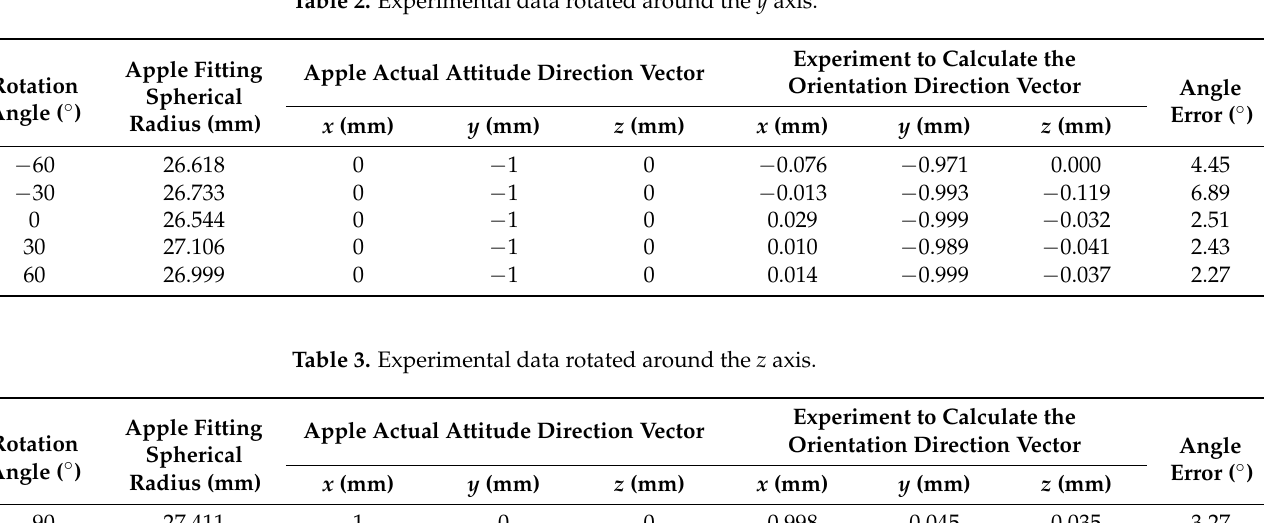
Table 2. Experimental data rotated around the y axis.